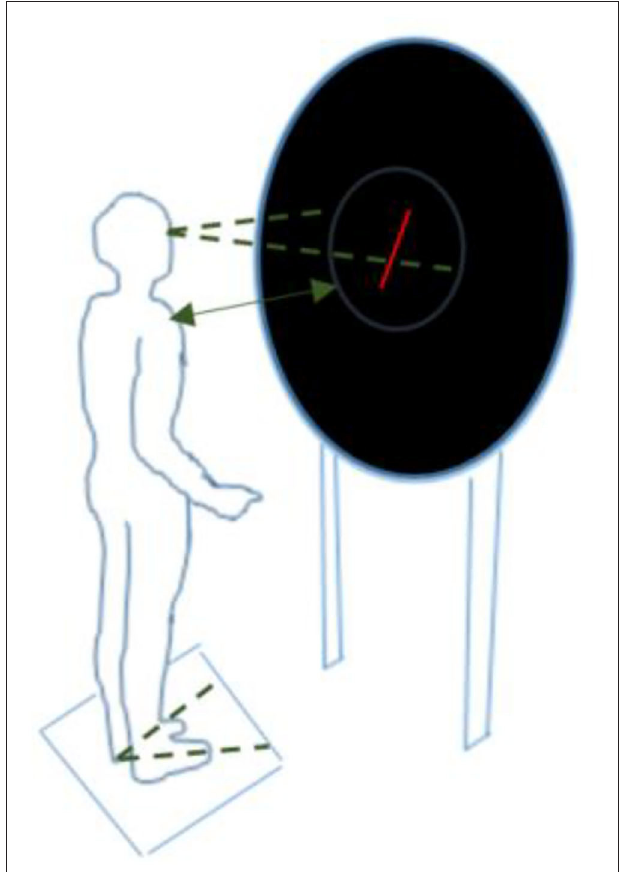
FIGURE 1 | Experimental setup for the Subjective Visual Vertical test, Rod-and-Disc test, and postural sway while facing rotating dots (screen display varied depending on the test condition) a,b . a The participant stood upright, barefoot, with arms alongside the body, in a completely dark room. A television screen was placed at eye level at a distance of 40cm, providing an almost full-field stimulus of 80%. A ring with an inner diameter of 54.5 was mounted on the television set to prevent the edges of the television screen from acting as a frame of reference. b The feet were placed at an angle of 20 degrees with the inner malleoli 10cm